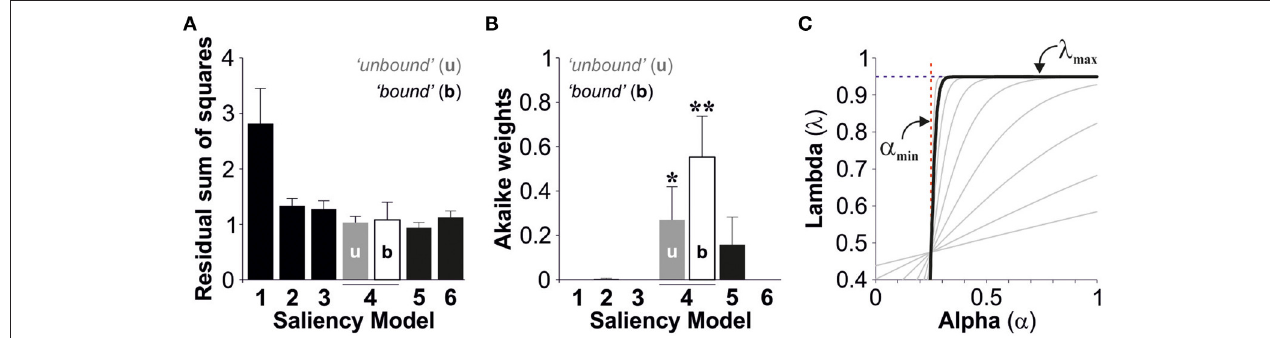
FIGURE 3 | Best model selection. The bar plots display the group average residual sum of squares (A) and the Akaike weights (B) for the saliency models tested (Average ± S.E.M). (C) Plot of lambda vs. alpha using the best parameter fits described in Figure 2 (“bound” conditions). The pattern resembles a Heaviside step function suggesting that lambda does not depend on